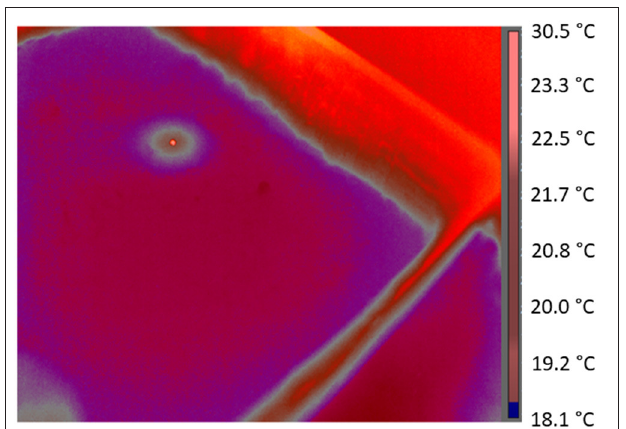
FIGURE 3 | Laboratory experiment with a fiber laser (50W, 2mm diameter) exposing the soil in a tray. The soil surface temperature was measured with an infrared camera. The temperature is only significantly increasing close to the spot (modified from Andreasen et al., 2021). FIGURE 4 | Dimensions of a prototype of an autonomous vehicle for laser